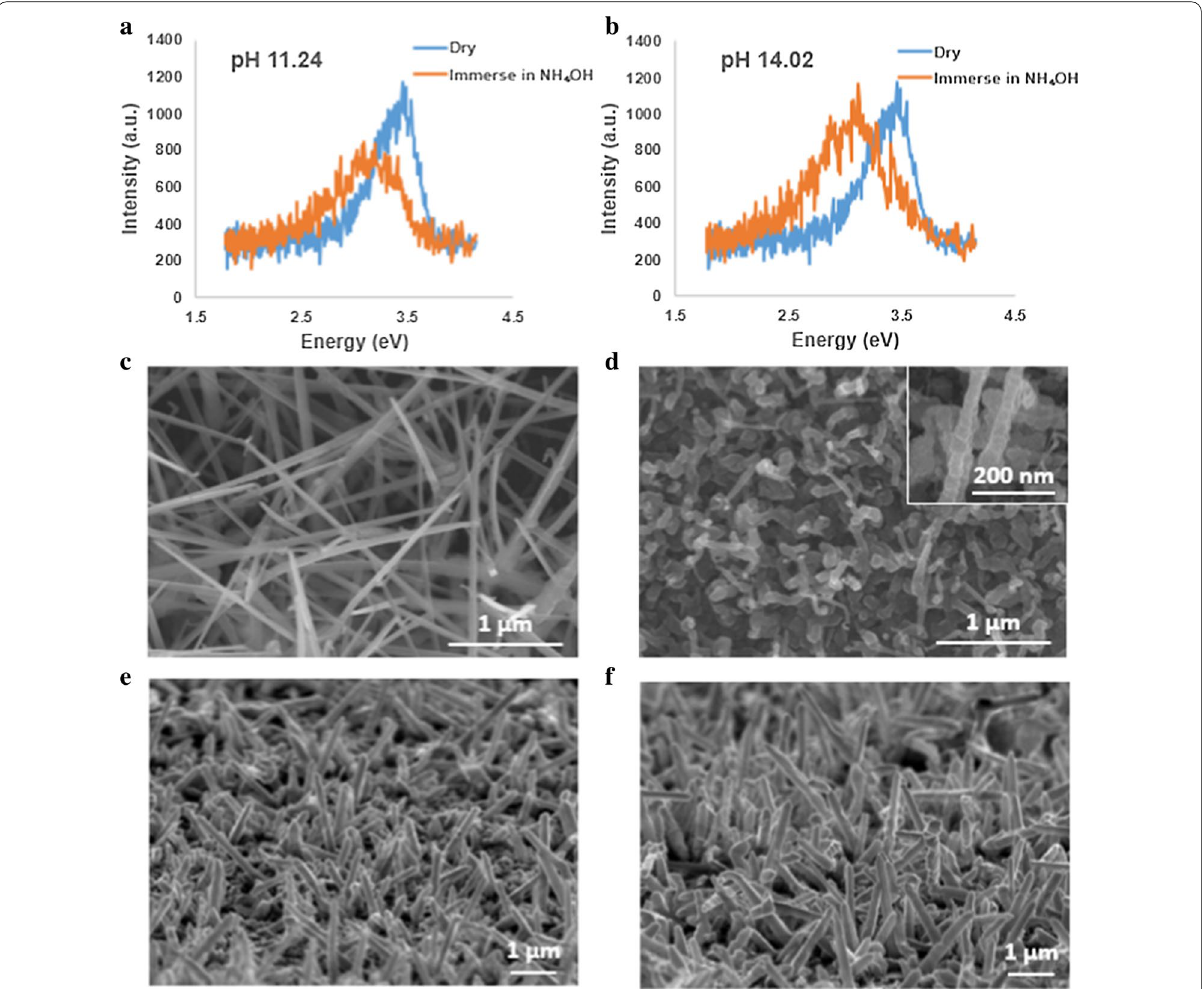
Fig. 7 The PL spectra of GaN nanowires in NH 4 OH and the corresponding SEM images. a Signals when nanowires are in NH 4 OH at pH Signals when nanowires are in NH 4 OH at pH 14.02. c SEM image of the as‑grown GaN nanowires. d The GaN nanowires after immersing in NH 4 OH = solution for 20 min. e SEM image of the as‑grown GaN nanowires. f The nanowires after the tests of immersing them into the acidic solution, HCl,